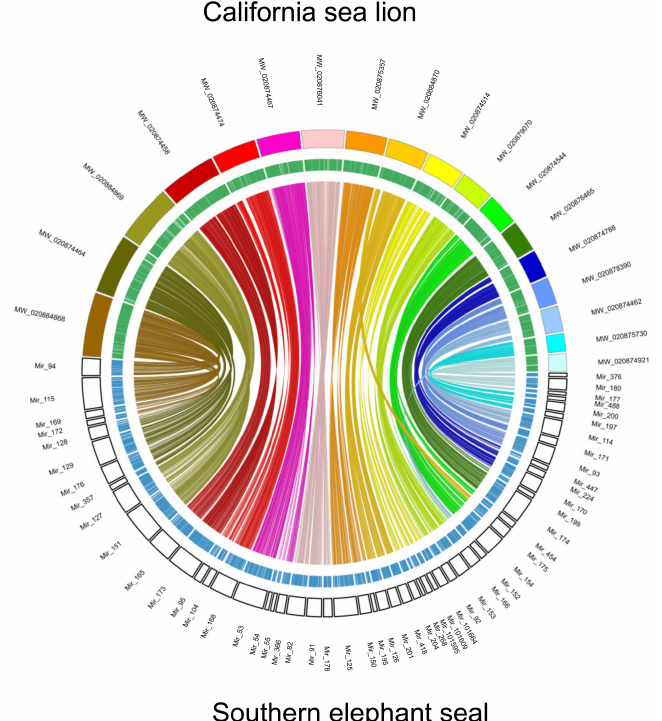
Figure 3. Synteny blocks between Southern elephant seal sca ff olds and 19 chromosomes of California sea lion (assembly zalCal2.2). Southern elephant seal sca ff olds over 10 Mb in length were selected. Alignment was accomplished with SyMAP v3.4. The color blocks represent California sea lion chromosomes and empty blocks represent Southern elephant seal sca ff olds. Green and blue bars represent genes of California sea lion and Southern elephant seal, respectively. Connections within the circle represent alignment between the two